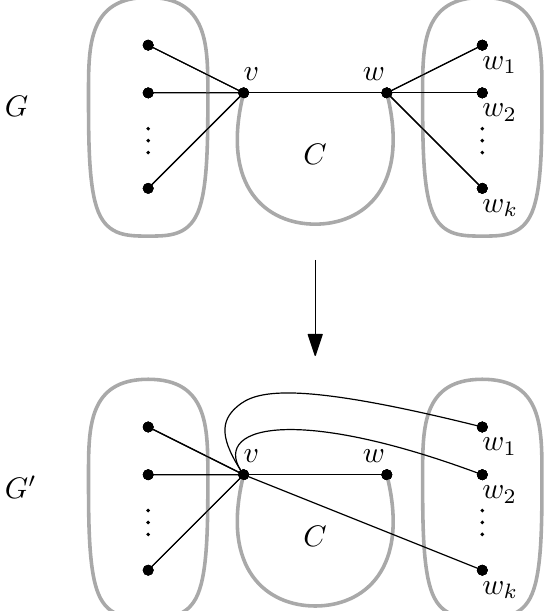
Figure 3. Transformation 1 used in the proof of Lemma 4, when the edge vw lies on the cycle of length greater than